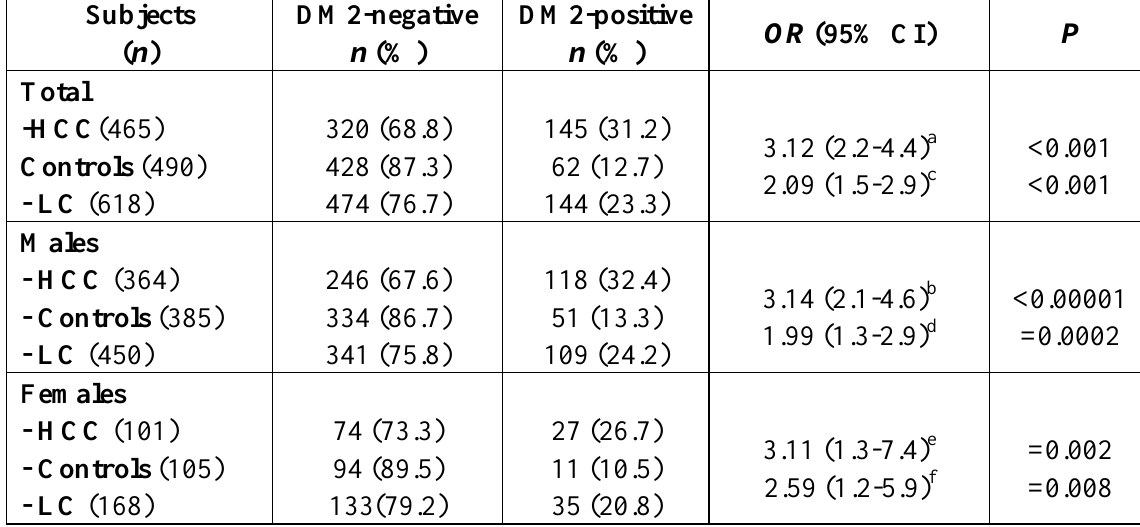
Table 2. Frequency of type 2 diabetes mellitus in HCC, LC and control groups.